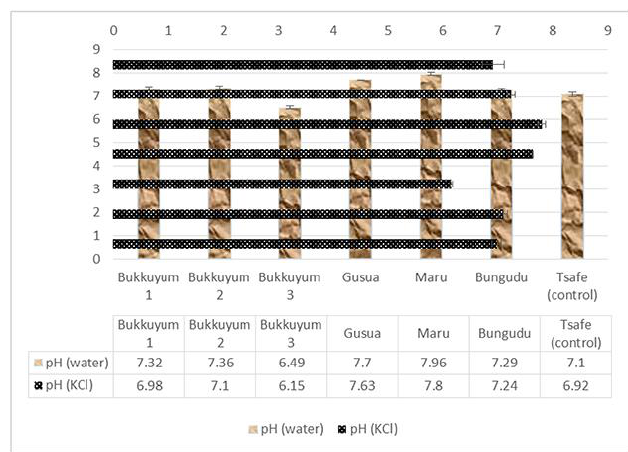
Figure 5: Mean ± SE of soil pH in water and KCl in the study area Table 8: pH range for standard